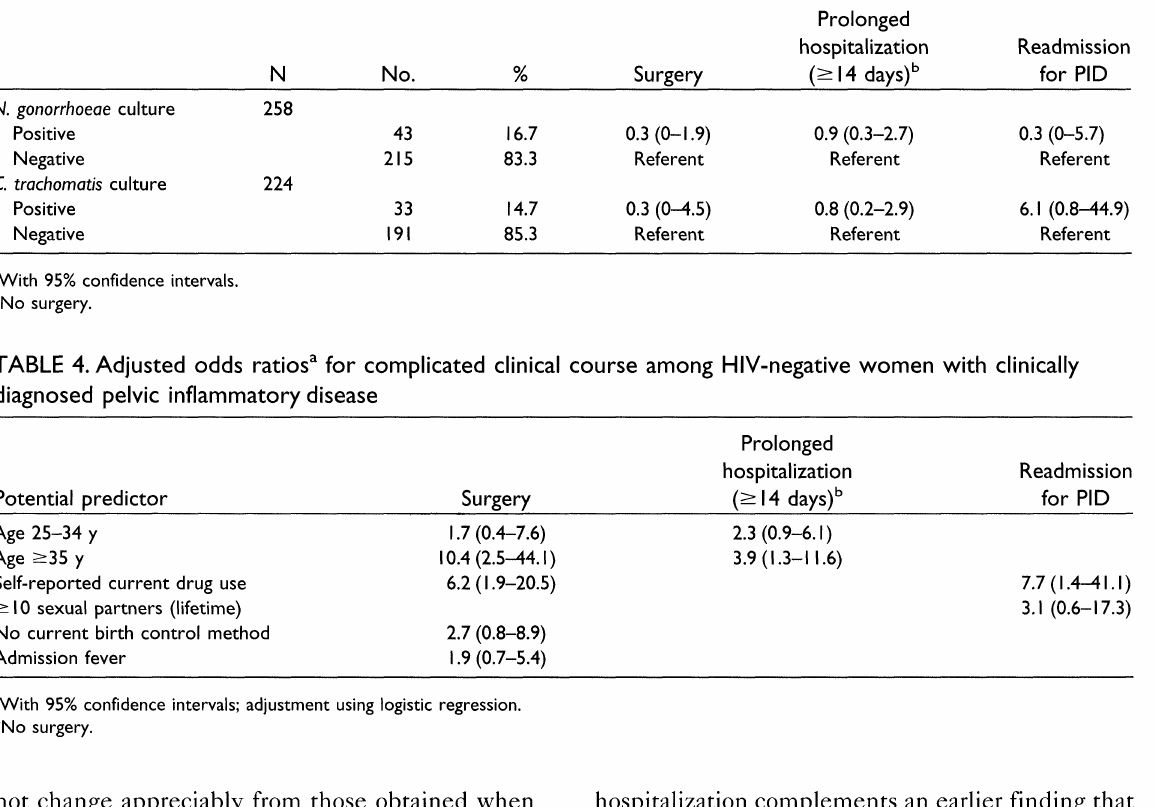
Prolonged hospitalization Readmission